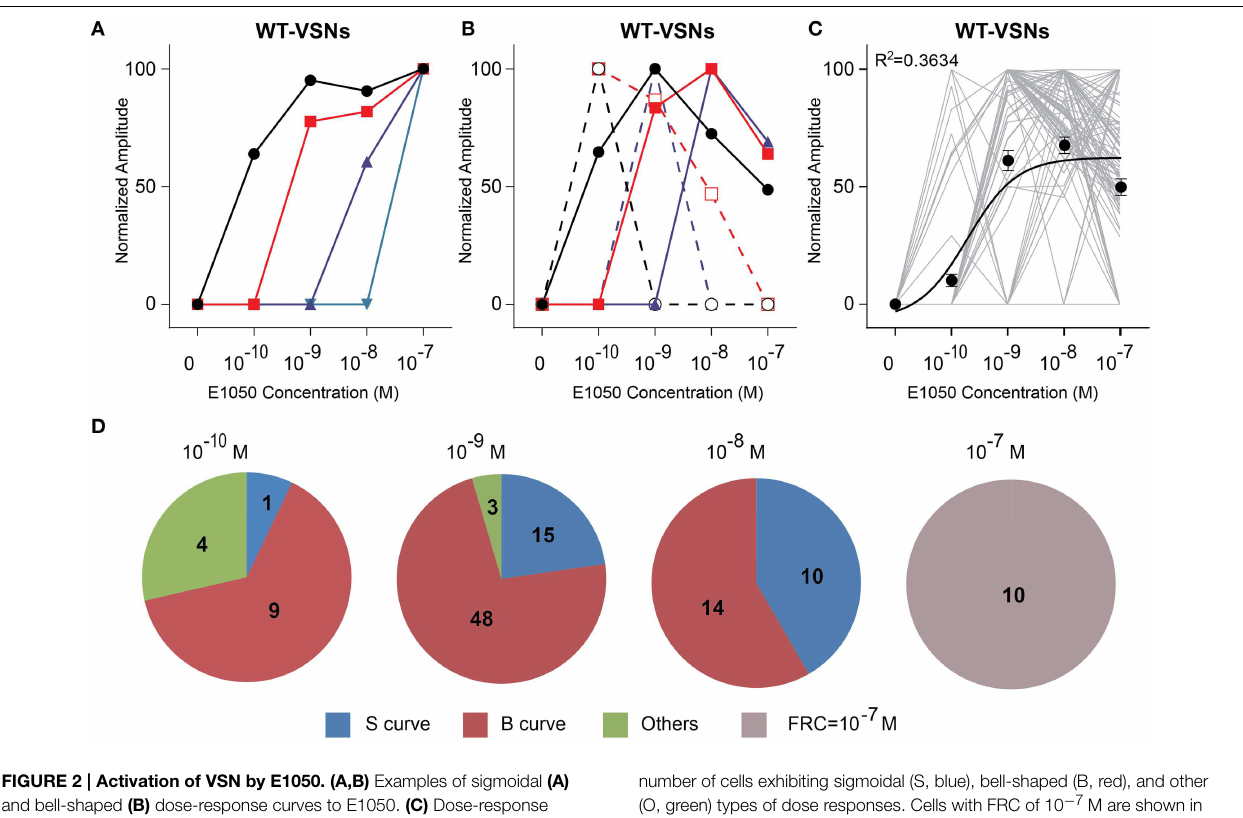
number of cells exhibiting sigmoidal (S, blue), bell-shaped (B, red), and other (O, green) types of dose responses. Cells with FRC of 10 − 7 M are shown in gray. Concentration above each pie chart represents the first response concentration of the